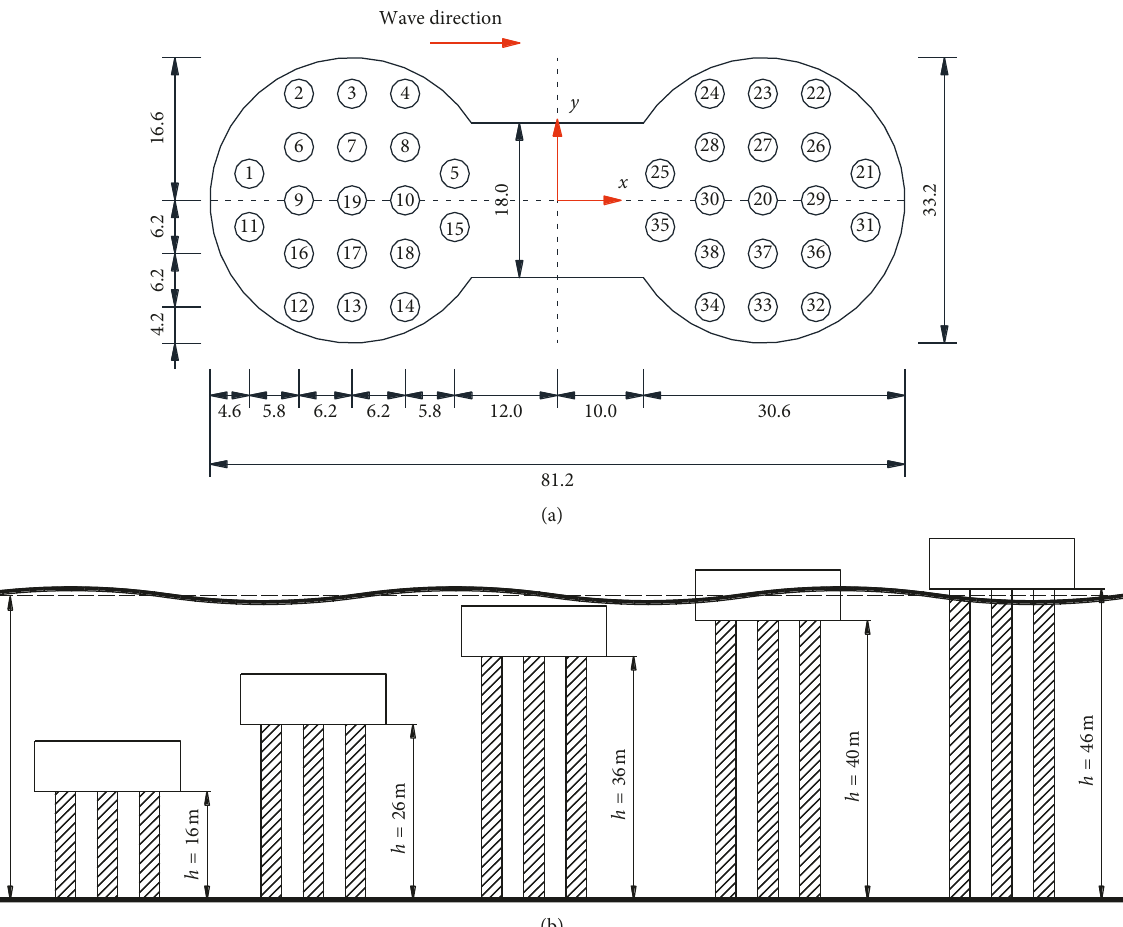
Figure 2: Computed pile foundations with different pile lengths. (a) Cross section. (b)